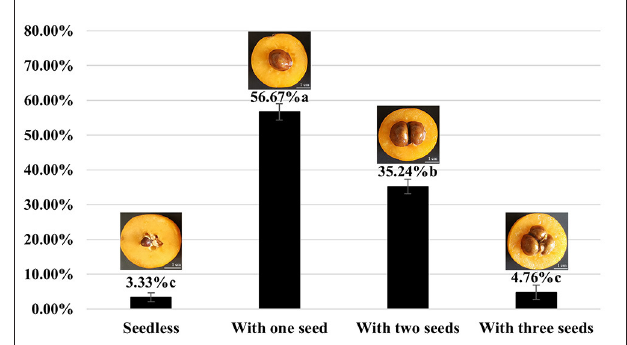
FIGURE 1 | The proportion of H30-6 open-pollinated fruits with different seed numbers. The statistical differences in means of the ratio of fruits with different seed numbers were determined using the LSD test; different letters beside the bar indicate that the means are significantly different ( P < 0.05); values are presented as mean ( ±